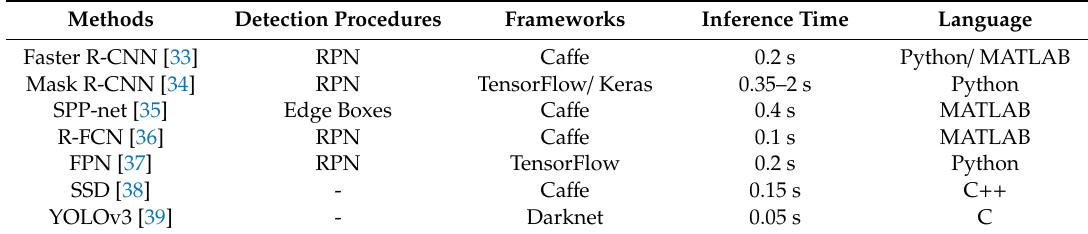
Table 2. Real-time object detection methods with their inference